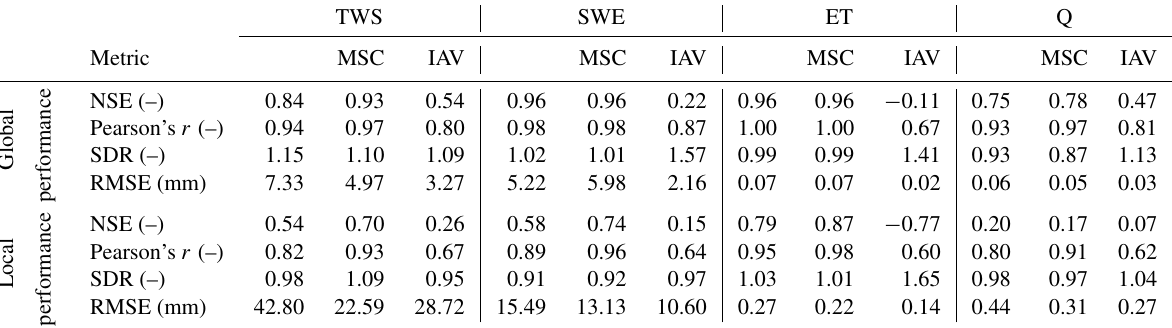
Table 3. The global (spatially averaged) and local (median cell level) model performance for the observational constraint variables terrestrial water storage (TWS), snow water equivalent (SWE), evapotranspiration (ET), and runoff (Q) and their decomposition into the mean seasonal cycle (MSC) and interannual variability (IAV). The Nash–Sutcliffe model efficiency (NSE), Pearson correlation ( r ), root mean square error (RMSE), and the ratio of modeled and observed standard deviation (SDR) are calculated for the test set, where values represent the mean across the 15 cross-validation runs. Positive values of SDR indicate that the modeled variance is larger than the observed. Note that, for the SWE, cells with constant 0 were dropped. The values were calculated for the test set in the range 2009 to 2014 on monthly timescale. TWS SWE ET Q Metric MSC IAV MSC IAV MSC IAV